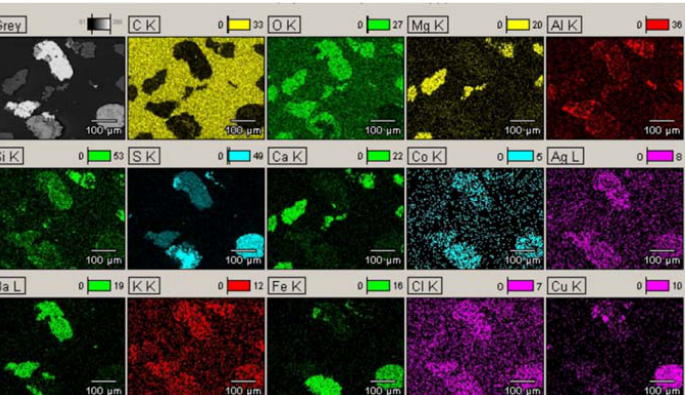
Figure 7. SEM–EDS analysis of heavy fraction of ZM. Representative SEM–EDS analysis, and distribution of chemical components in ore and gangue minerals: Fe-Cu-S indicate sulphides, Ba-S-O indicates sulphates, Si-Al-K indicates silicates (K feldspars), Mg-Ca indicates carbonates. As in the copper content, the content of silver and arsenic is variable. In the 5 m profiles, the highest value (very high, hurricane value or sample), of up to 6250 ppm, evidently differs from the remaining ones. The mean copper content, determined